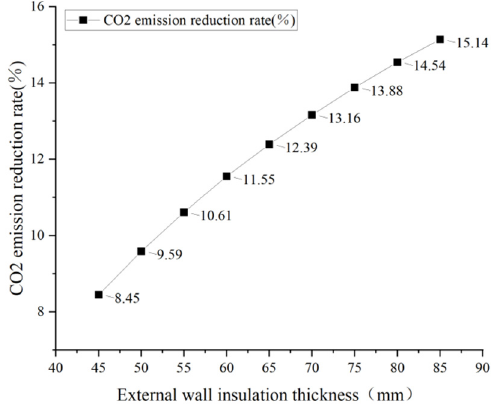
Figure 4. CO 2 emission reduction rate of different external wall insulation thicknesses.